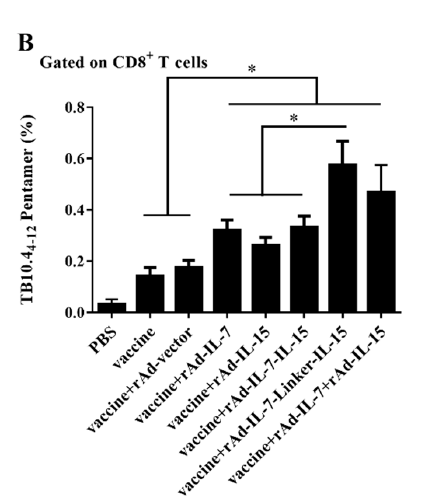
Figure 3. Number of expanded TB10.4-specific CD8 + T cells in spleens. Mice were injected with BCG by i.p. at 20 weeks after the final immunization. After 9 days, the number of TB10.4-specific CD8 + T CM like cells was evaluated by TB10.4 4-12 pentamer. ( A ) The representative results of every group; ( B ) Frequency percentages of TB10.4-specific CD8 + T CM like cells. Data collected were presented as means ± SD from 5 mice per group. * p < 0.05.